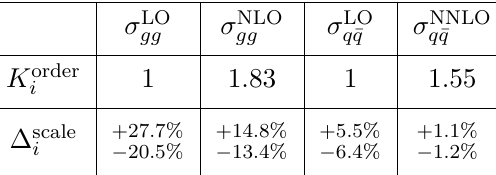
= σ order /σ LO , for the channels i = gg , q ¯ q at different i i i for each channel i